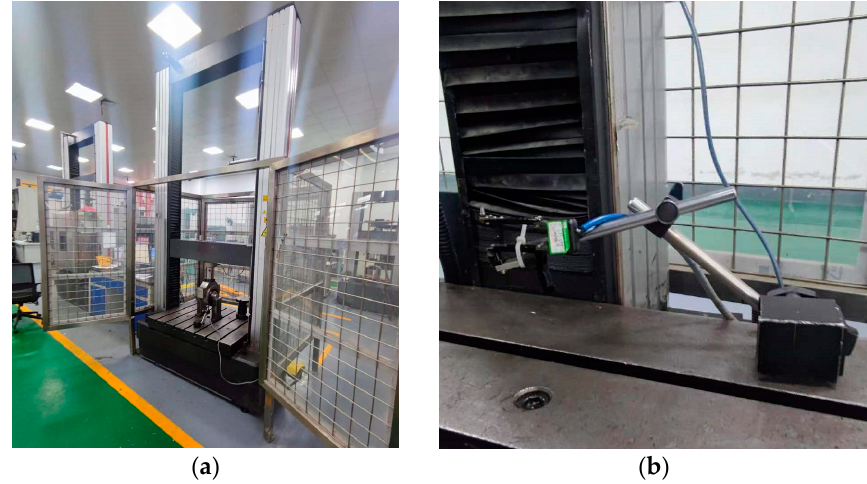
Figure 4. Experiment facilities including the ( a ) loading equipment and ( b ) displacement sensor.